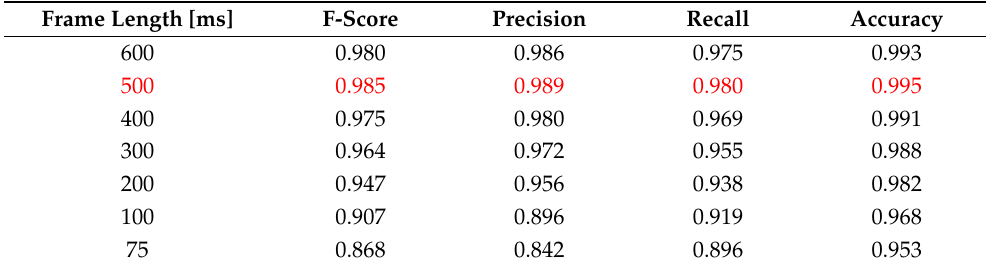
Table 10. Effects of the length of the signal frame on the performance of the LSTM-based fault